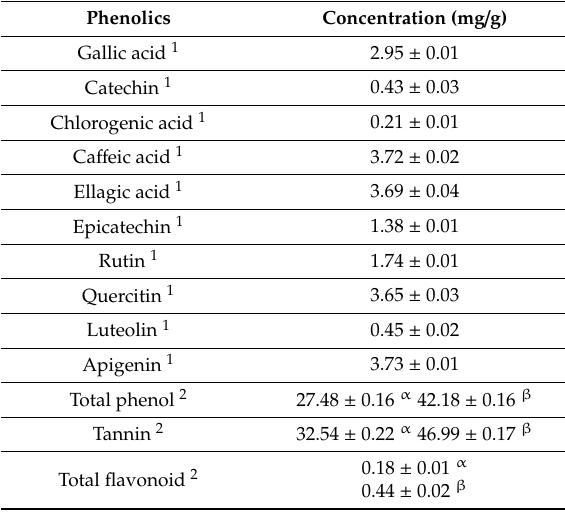
Table 3. Phenolics constituent of prekese